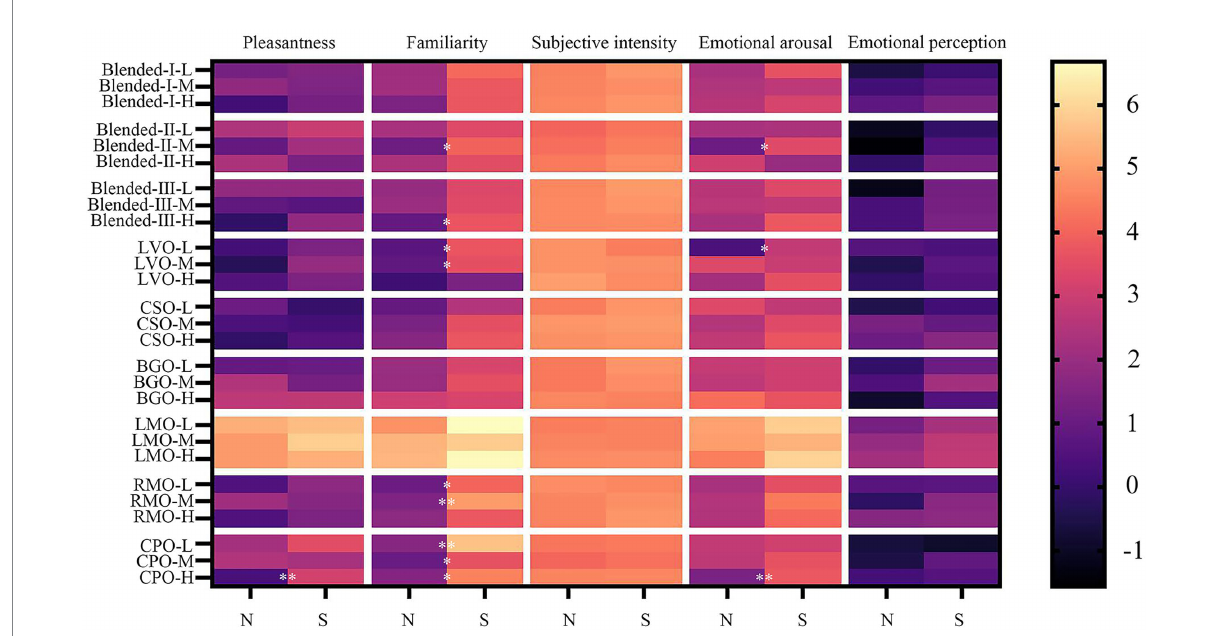
FIGURE 4 Effect of regional culture on sensory evaluation of odor. Mean ratings ( n = 25) at three concentrations on pleasantness, familiarity, subjective intensity, emotional arousal, and emotional perception at low (L), mid-range (M), and high (H) concentration of the participants from the northern Yangtze and the southern Yangtze. N: participants from the northern Yangtze, S: participants from the southern Yangtze. The asterisk indicates that the odor evaluation results of the two groups show significant differences. * p < 0.05, ** p < 0.01. Data were analyzed by main effects analysis with two-way mixed ANOVAs, a post hoc Bonferroni test was